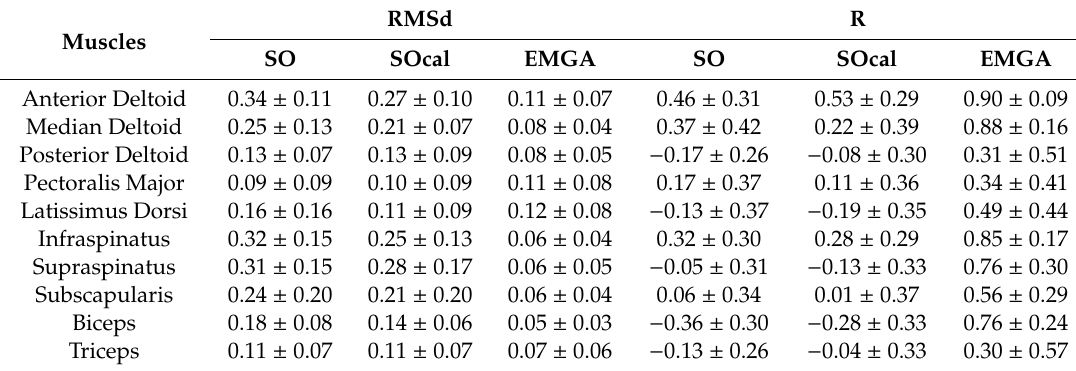
Figure 2. Net Adjusted EMG (EMGA: blue) and experimental EMG (Exp: red). * No experimental data (solid line: mean value, shaded region: 95% confidence interval). Table 2. RMSd and R related to the muscle activations predicted by SO on the uncalibrated (SO) and calibrated model (SOcal) and the EMG adjusted with the EMG-assisted method (EMGA), in comparison to the experimental EMG.